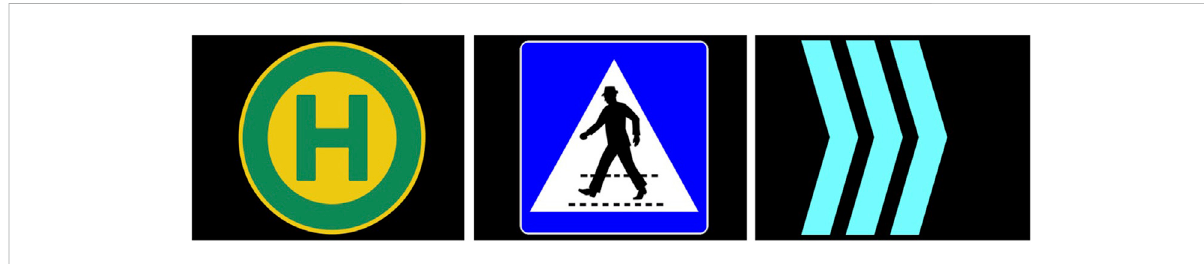
FIGURE 4 eHMI design icons and arrows as applied for the fi eld study.